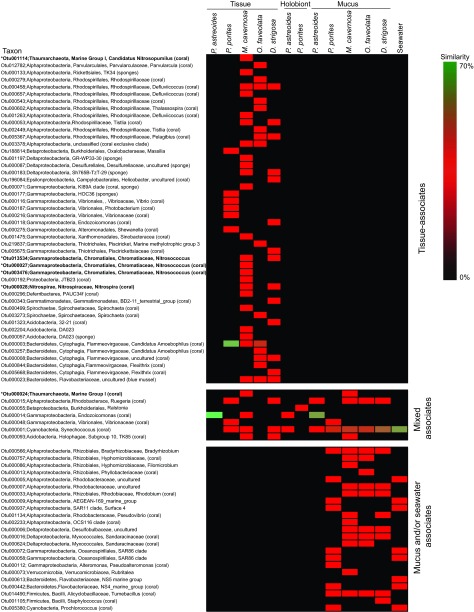
Heatmap displaying consistent similarity-based OTU results based on SIMPER intragroup similarity analyses for the tissue, mucus, holobiont, and seawater samples (12 to 15 samples for corals, 10 samples for seawater). The similarity bar to the right of the heatmap indicates high SIMPER scores (70% maximum, green) to very low SIMPER scores of <1% or zero (black) with the middle of the scale representing the median percentile score. Sequences that have previously been associated with corals or sponges are noted, and sequences associated with genera containing known nitrifiers are indicated with an asterisk and shown in bold type.